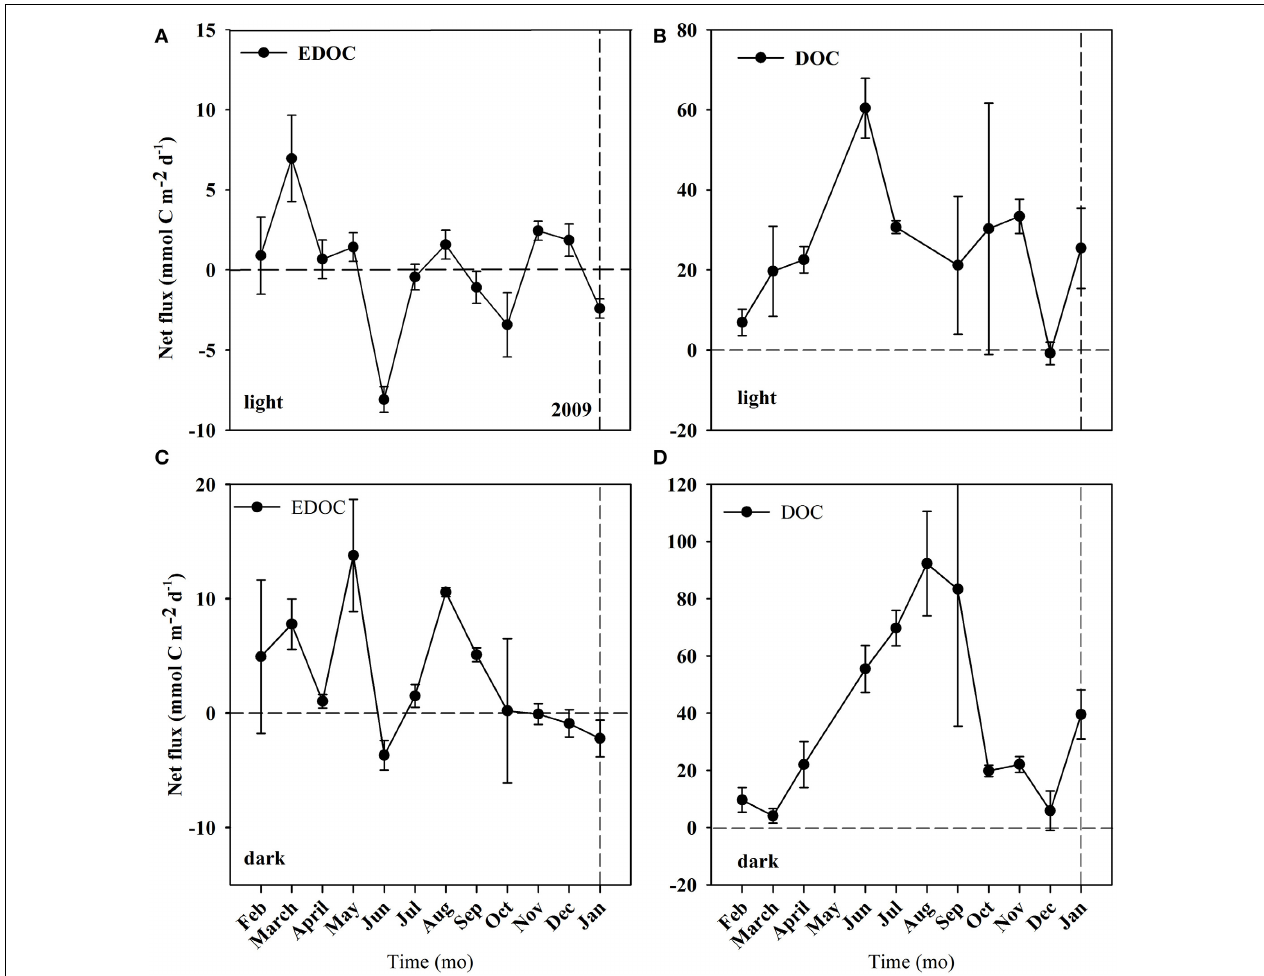
FIGURE 4 | Net fluxes of EDOC and DOC from the C. prolifera community over time. Mean ± S.E. Panel (A) corresponds to EDOC incubations in the light. Panel (B) corresponds to DOC incubations in the light. Panel (C) corresponds to EDOC incubations in the dark. Panel (D)